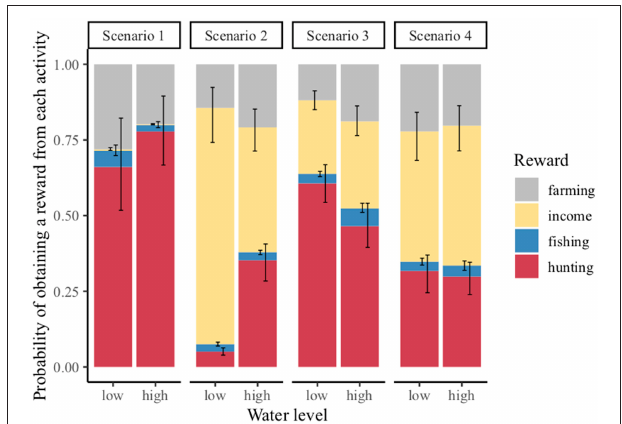
FIGURE 9 | Protein sale model. The colored areas correspond to the probability of selling each protein type at every season and scenario. The confidence intervals are the 95th percentile intervals, as calculated from the posterior samples of the model. In gray is the reference level (reward from farming).